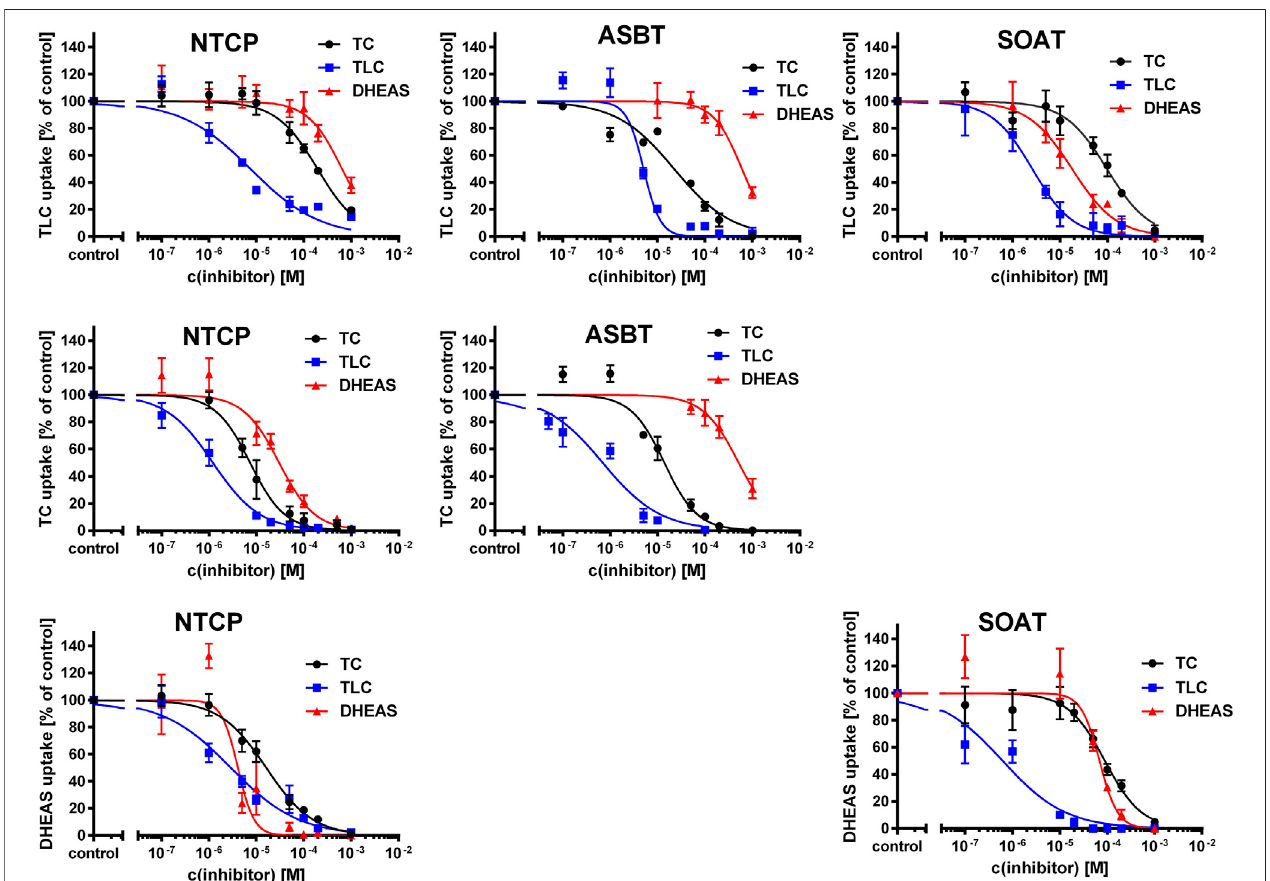
FIGURE 3 | Inhibition of NTCP, ASBT, and SOAT with substrate inhibitors. Transport of [ 3 H]TC, [ 3 H]TLC, and [ 3 H]DHEAS was analyzed in NTCP-HEK293, ASBT- HEK293,and SOAT-HEK293cellsinthe presence ofthesubstrate inhibitors TC, TLC, and DHEAS at increasingconcentrationsrangingfrom100 nM till 1000 µM.After 5 min of preincubation with the respective inhibitory compound, 200 nM [ 3 H]TLC, [ 3 H]TC or [ 3 H]DHEAS were added for additional 1 min and the cell lysates were analyzed by liquid scintillation counting. Unspeci fi c uptake of HEK293-FlpIn cells was set to 0%. Carrier-speci fi c uptake without inhibitor was set to 100%. IC 50 values were calculated by sigmoidal dose-response (variable slope) with a goodness of fi t ≥ 0.95 (GraphPad Prism software, version 6.05). IC 50 values are listed in Table 3 .